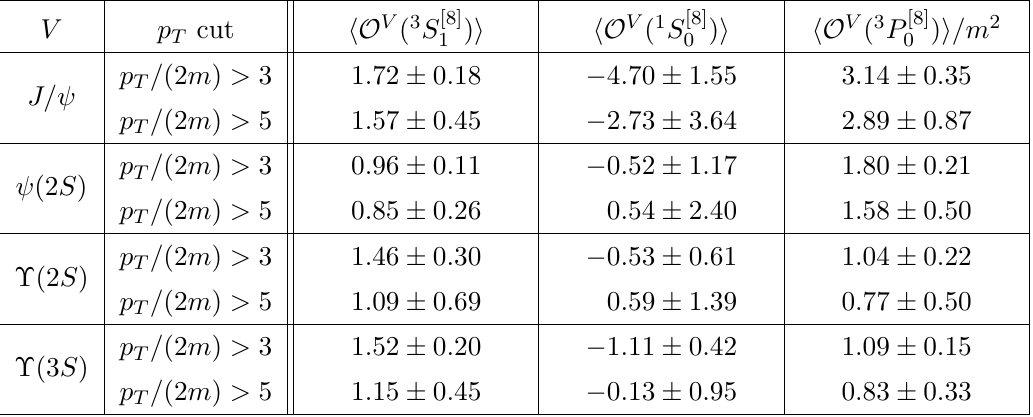
Table 3 . The color-octet LDMEs for V = J/ψ , ψ (2 S ) , Υ(2 S ) , and Υ(3 S ) in units of 10 − 2 GeV 3 obtained by excluding cross section measurements of V from fits, for p T cuts p T / (2 m ) > 3 and p T / (2 m ) > 5 . The 3 S [8] LDME is renormalized in the MS scheme at scale Λ = m 1